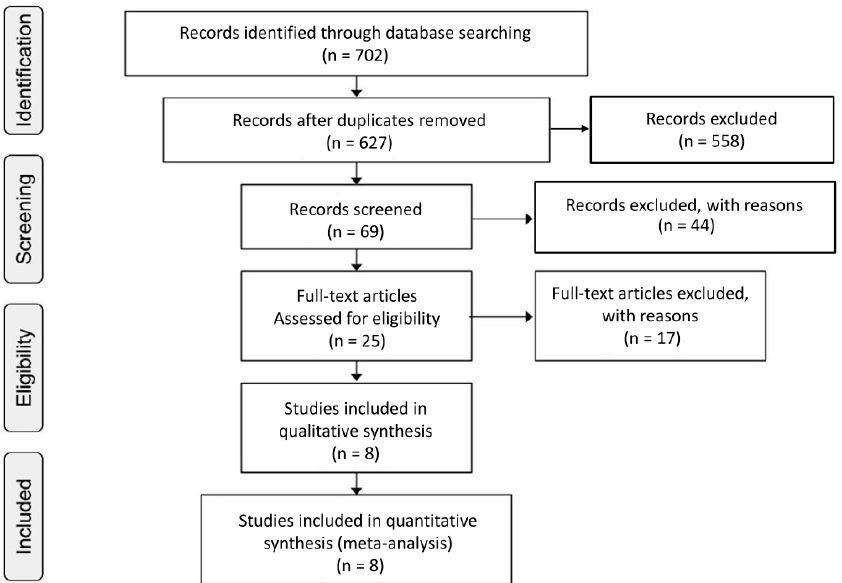
Figure 1. Flow chart of the systematic literature search for the meta-analysis.